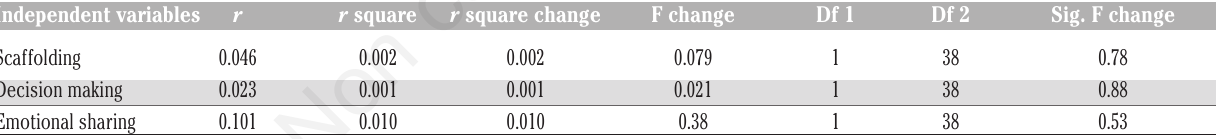
levels. Only the corporealness scale reports a slightly negative score got by the control group